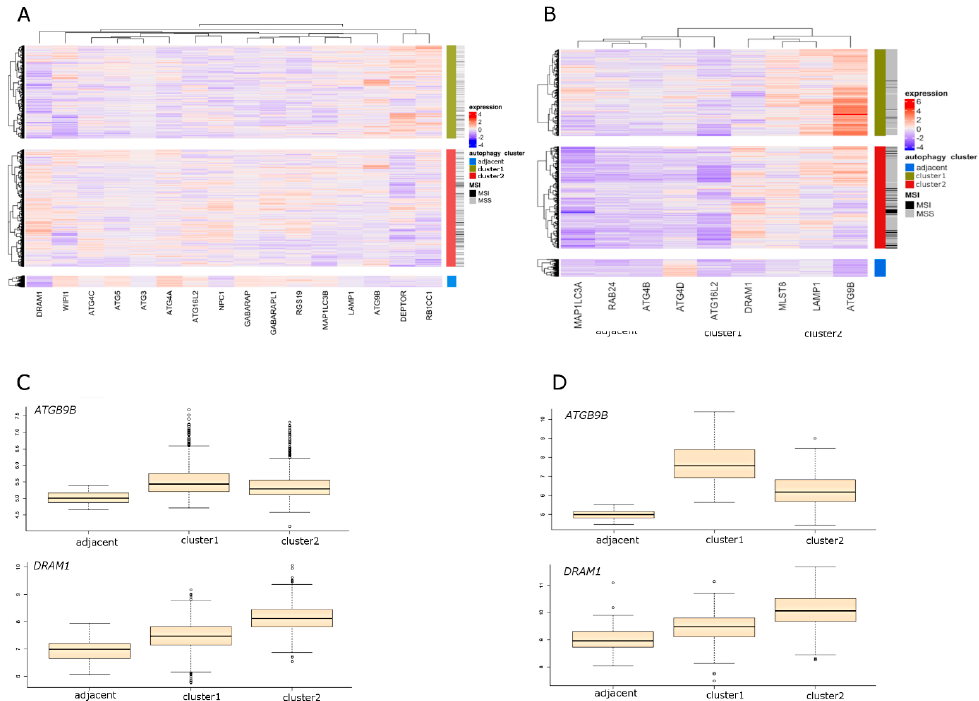
Figure 1. Results of unsupervised clustering and partial last squares discriminant analysis PLS (sPLS-DA) of colorectal cancer (CRC) datasets (RNA-seq and array) using selected autophagy-related genes. Samples were separated based on unsupervised clustering, and visualized genes were selected according to sPLS-DA [( A )—CRC array; ( B )—CRC RNA-seq]. The corresponding box plots illustrate the expression distribution of the most highly ranked genes in terms of separation of clusters. [( C )—CRC array; ( D )—CRC RNA-seq]. MSI: microsatellite instability; MSS: microsatellite stability.